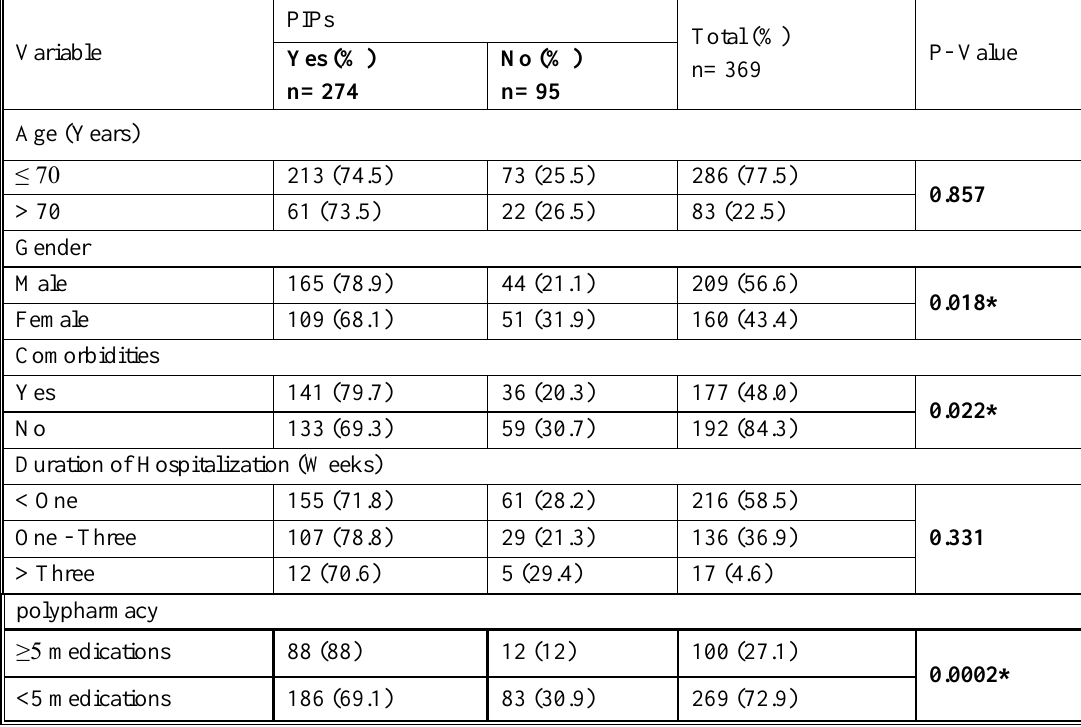
*Significant difference according to the chi-square